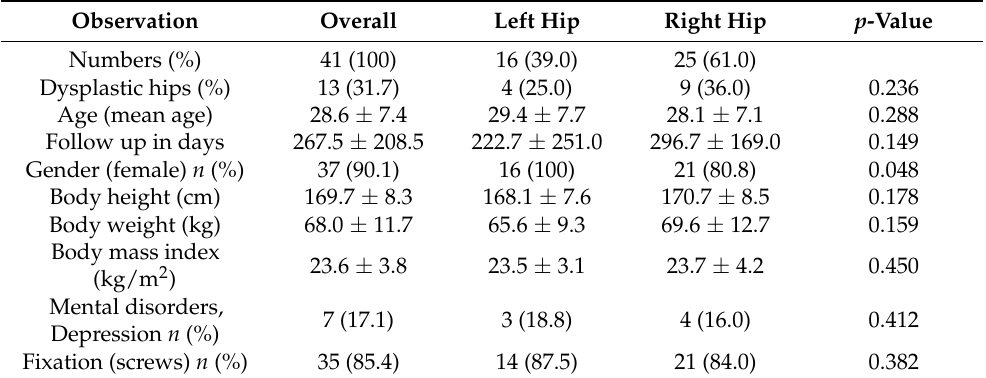
Table 1. Demographics of included patients and significance between the two groups.